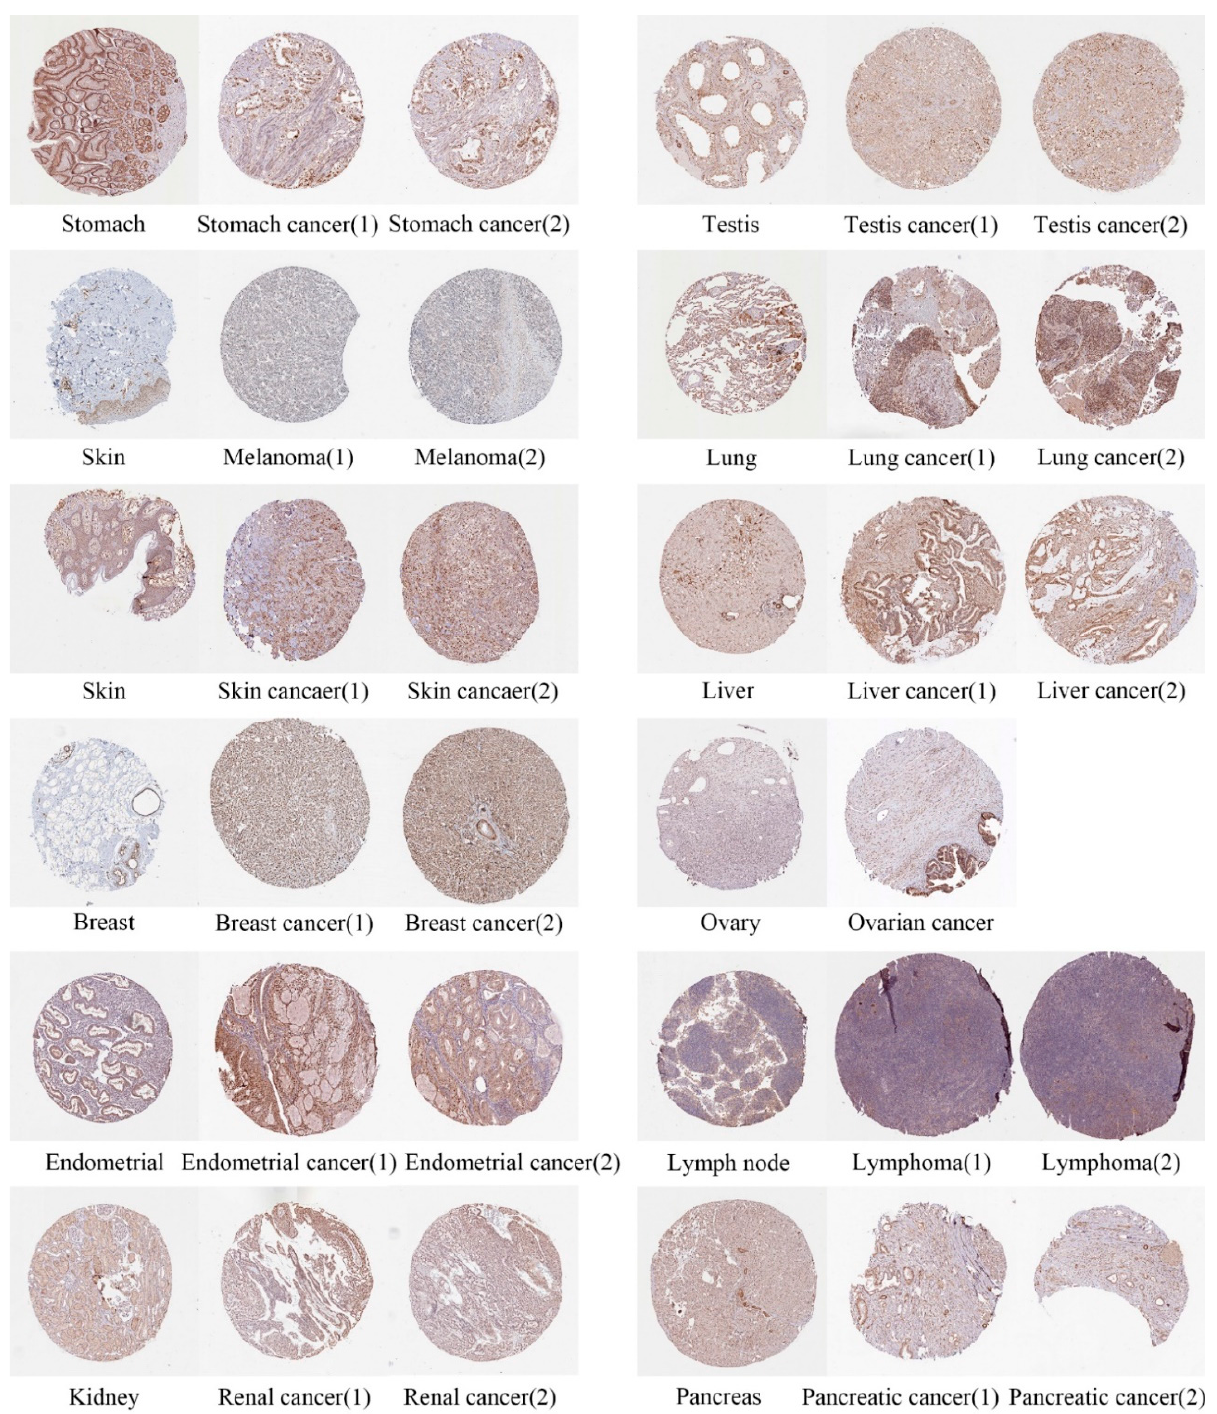
Figure 2. Immunohistochemical images of differential expressions of GNL3L protein in 12 tumors.